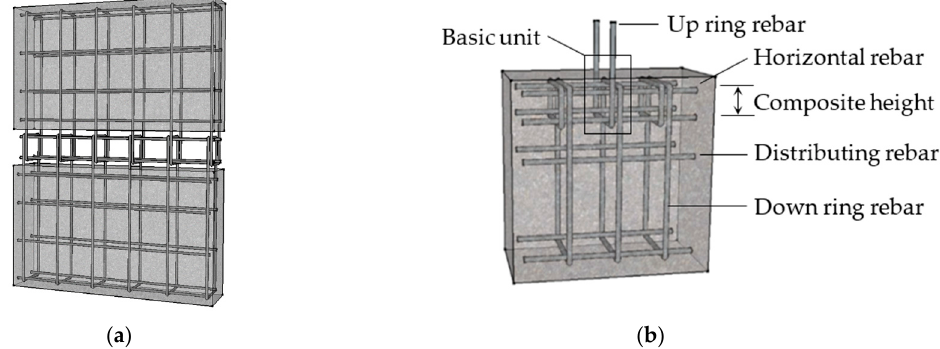
Figure 1. Schematic diagram of the ring joint connection. ( a ) Connection diagram; ( b ) Specimen schematic.